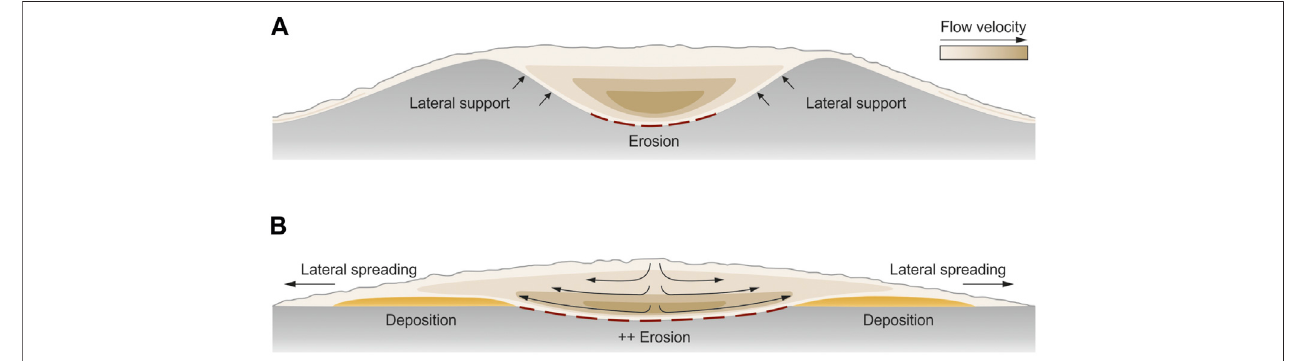
FIGURE7| The fl owrelaxationmodel. (A) Con fi ned fl owinareferenceexperimentatthesamepointontheslopeasin (B) . (B) Largelyuncon fi ned fl owdownstream of a loss of con fi nement, marked by fl ow relaxation consisting of lateral spreading and downward movement of fl ow towards the base, lowering the position of the downstream velocity maximum, and therefore increasing basal shear stresses and enhancing erosion. Modi fi ed from Pohl et al. (2019).